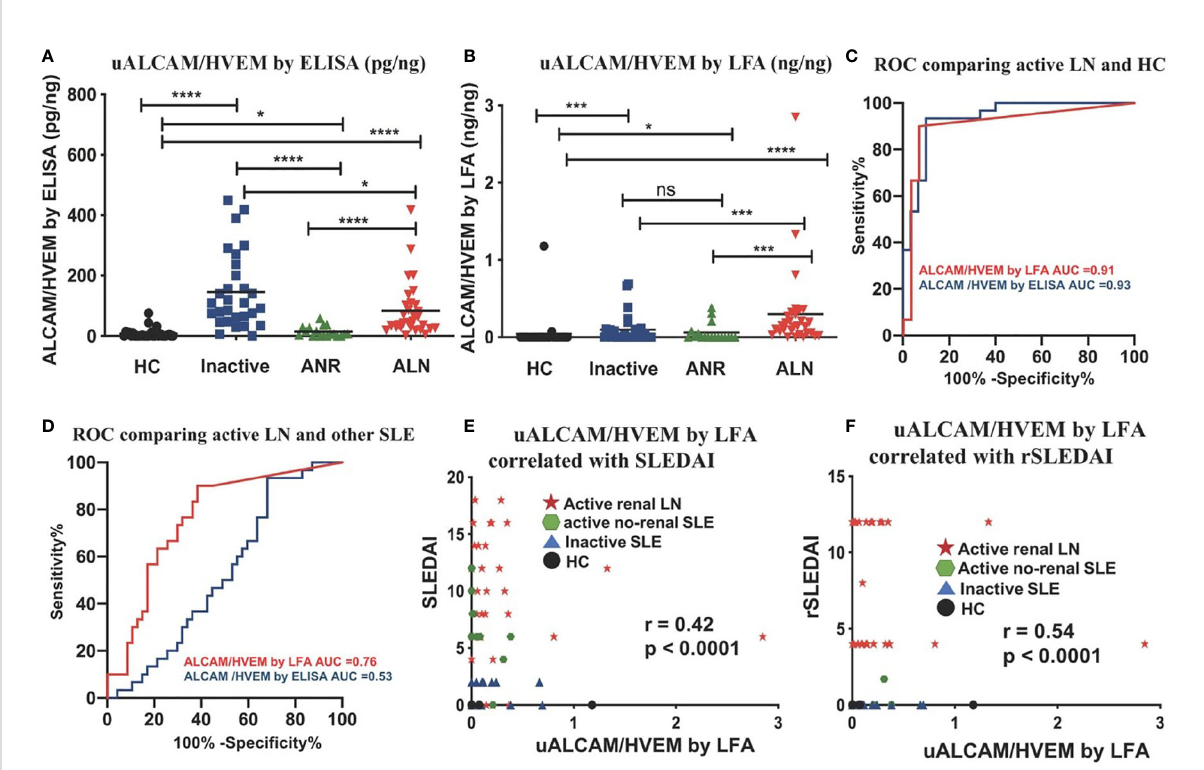
FIGURE 8 Comparing normalized uALCAM detection using ELISA and LFA in clinical samples. The column graphs show the uHVEM normalized uALCAM levels in four groups of subjects (30 HC, 29 inactive, 18 ANR, and 30 ALN) as assayed by ELISA (A) and LFA (B) The plots show the mean concentration in urine for each disease group. *p < 0.05, ***p < 0.001, ****p < 0.0001 as determined using Mann – Whitney U-test. (C, D) HVEM normalized uALCAM as assayed using the LFAs had the capability to distinguish ALN patients from healthy subjects with high accuracy values (ROC AUC = 0.91) and from all other lupus patients (ROC AUC = 0.76), and were signi fi cantly (Spearman) correlated with the disease activity metrics, SLEDAI (E) and rSLEDAI (F) . HC, healthy control; inactive, inactive SLE patients; ANR, active non-renal SLE patients; ALN, active